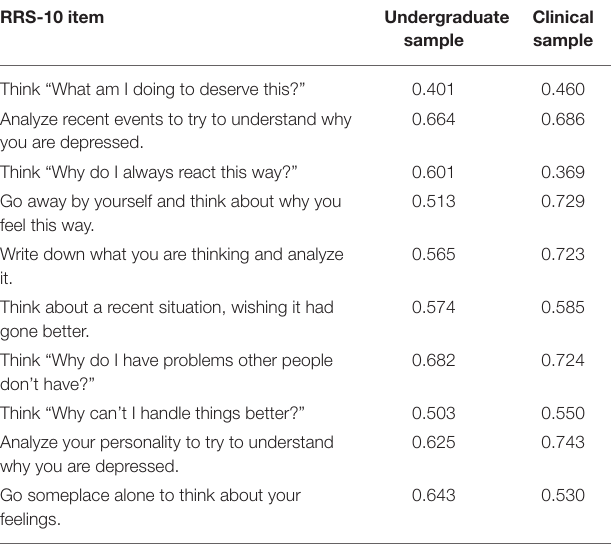
TABLE 5 | The factor loadings of each item in RRS-10. RRS-10